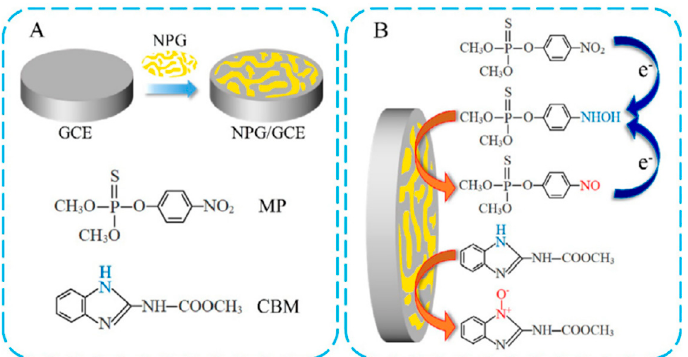
Figure 2. Schematic presentation of the ( A ) modified GCE by nanoporous gold (NPG) used for simultaneous detection of carbendazim (CBM) and methyl parathion (MP) pesticides, and ( B ) elec- trochemical reaction principles of both pesticides on the surface of the NPG-GCE. Reprinted with permission from Ref. [46]. Copyright 2019 Elsevier